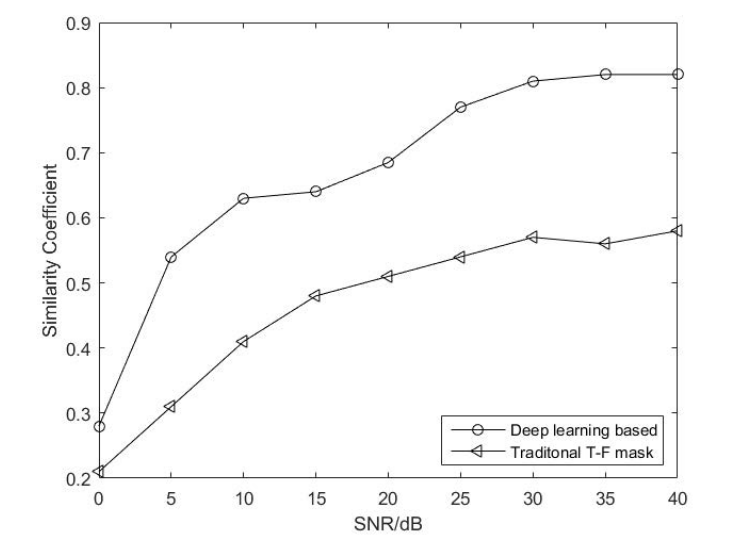
Figure 12. Comparison of similarity coefficients under different noise backgrounds.